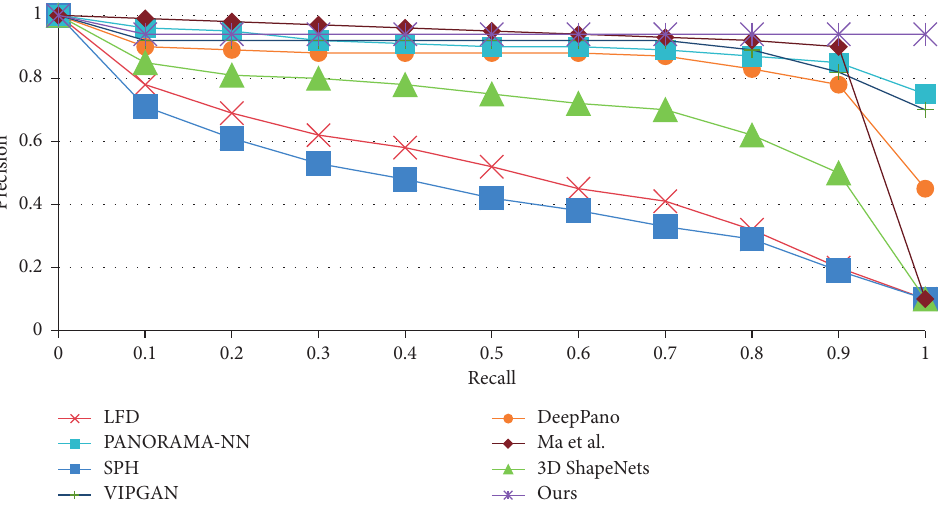
Figure 10: The comparison of precision-recall curves for various methods on ModelNet10.